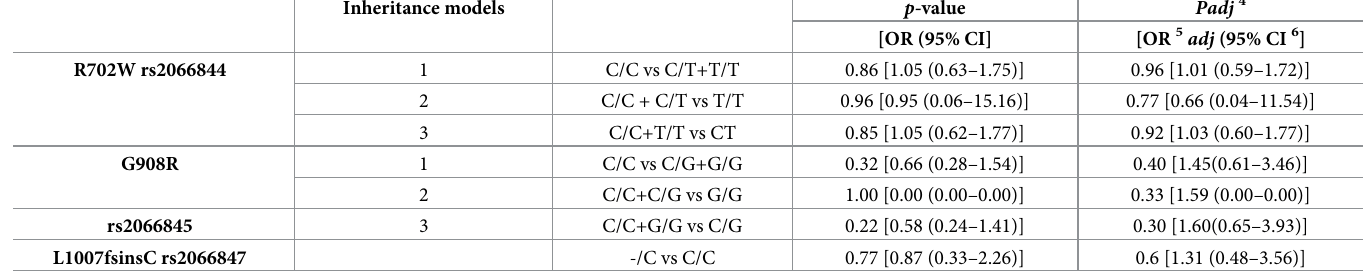
Table 3. Statistical comparisons between patients with Lg -CL and healthy controls based on inheritance models with p-values and odd ratios adjusted for age and sex. Inheritance models